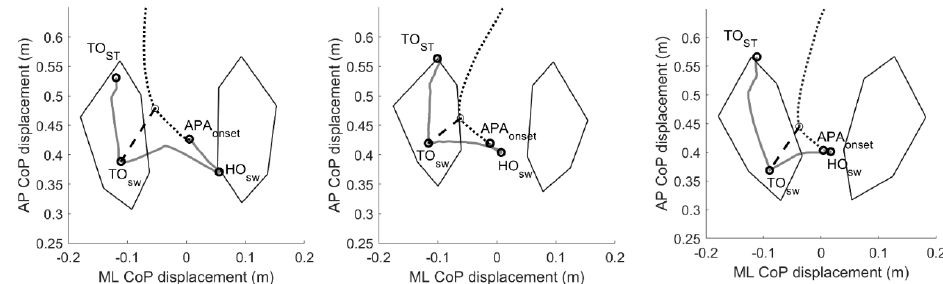
Figure 2. Two-dimensional center of pressure and center of mass trajectories during gait initiation. Example of the pathway of the center of pressure (CoP, grey solid line) and center of mass (CoM, black dotted line) during a gait initiation trial of one healthy subject (left panel) and one Parkin- sonian patient without (PDNF, central panel) and one patient with (PDF, right panel) a positive history of freezing of gait. We defined the imbalance (IMB) phase as the interval between the onset of the APAs (APAONSET) and the heel-off of the swing foot (HOSW), and the unloading phase (UNL) as the interval between the HOSW and the toe-off of the swing foot (TOSW). The black dashed line represents the CoP–CoM vector at the end of the unloading (UNL) phase. With respect to healthy controls, the CoP displacement during the IMB phase was reduced for both PD and PDF patients. The CoP displacement during the UNL phase was in most cases backwards for the PDF patients only. Please see Table 3 for further details. Abbreviations: APAs, anticipatory postural ad- justments; AP, anterior–posterior; CoP, center of pressure; HC, healthy controls; HO, heel off; ML, mediolateral; PDF, Parkinson’s disease with freezing of gait; PDNF, Parkinson’s disease with no freezing of gait; TO, toe-off. 3.4. Relationship between the Standing Postural Profile and the GI We did not find any significant correlation between the postural angles and the GI measurements. However, when not correcting for multiple comparisons, the shank angle was predictive for velocity variables of the IMB phase. The results are shown in Table 5. Table 5. Correlation between the shank angle and gait initiation measurements. Only significant partial correlations between postural angles and gait initiation measurements corrected for the in- fluence of the group variable are shown (Spearman’s ρ , p -value < 0.05). No correlation was signifi- cant after Bonferroni correction for multiple comparisons. Spearman’s ρ